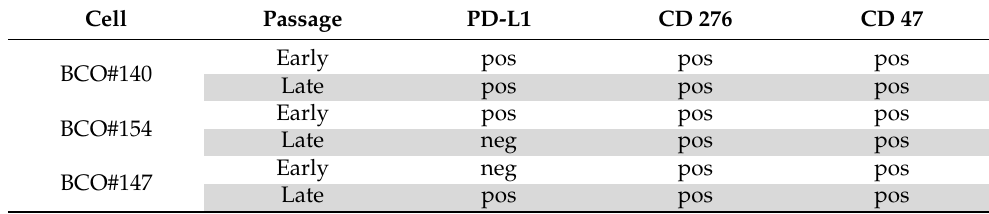
Table 3. Expression of immune regulatory antigens in paraffin sections of bladder cancer organoids 3